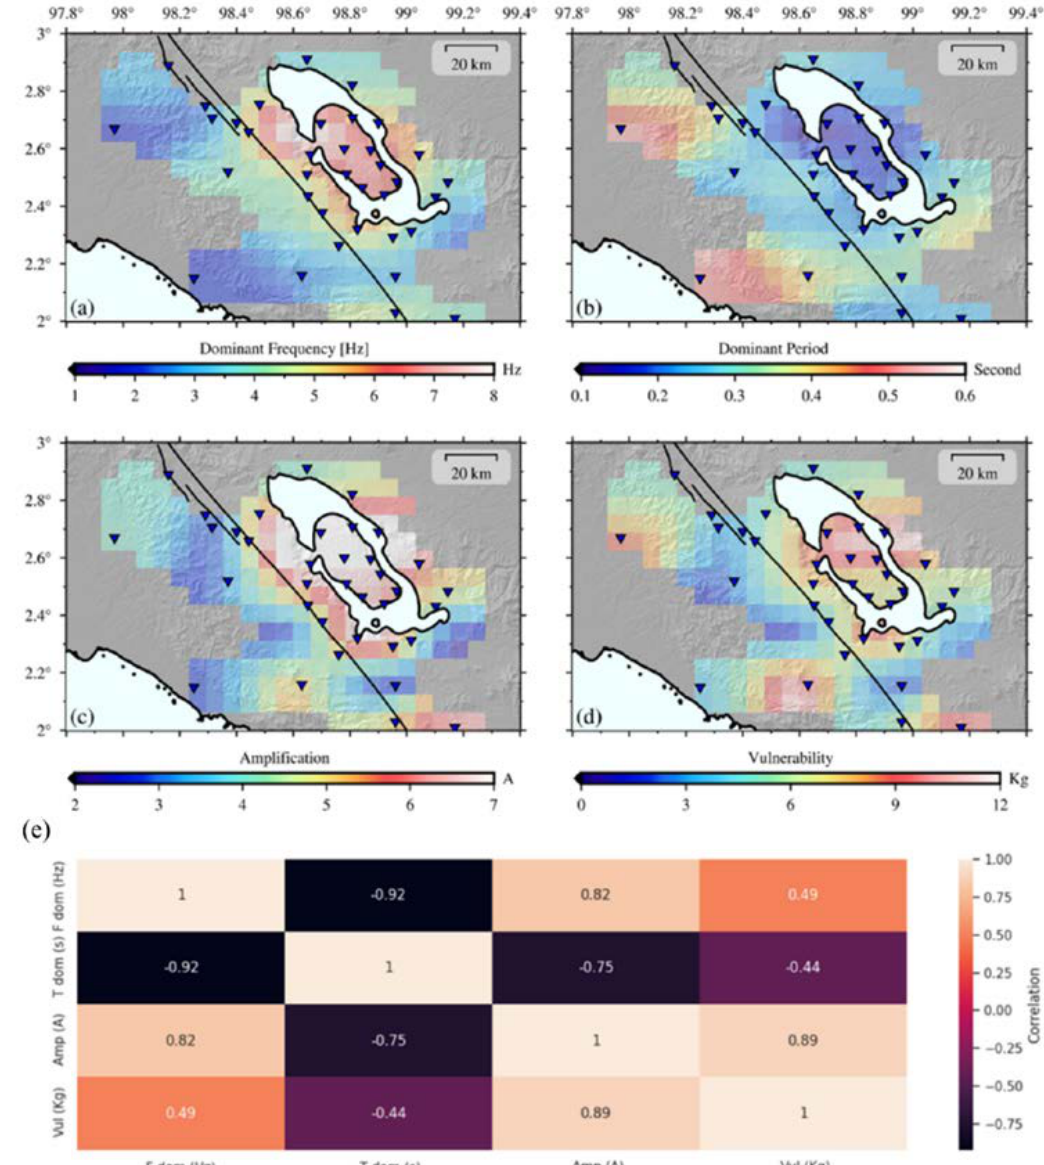
Fig. 6: (a) Spatial interpolation results of the HVSR result in dominant frequency, (b) dominant period, (c) amplification, and (d) vulnerability. (e) The heat map graphic explains the relationship between microtremor results and the correlation to all parameters.